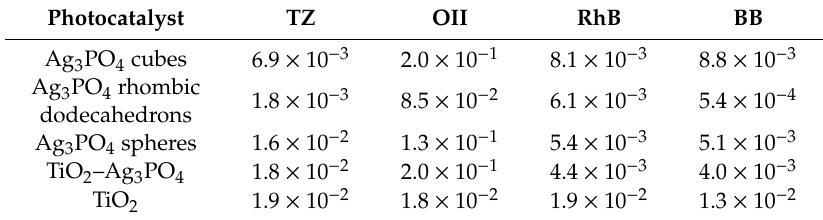
Figure 4. Relative concentration of tartrazine (TZ) ( a ), Orange II (OII) ( b ), rhodamine blue (RhB) ( c ), and Brilliant Blue FCF (BB) ( d ) vs. time in the presence of Ag 3 PO 4 cubes ( ● ), Ag 3 PO 4 rhombic dodecahedrons ( ▲ ), Ag 3 PO 4 spheres ( ▼ ), hybrid Ag 3 PO 4 –TiO 2 ( ♦ ), or TiO 2 ( ■ ) under 420 nm irradiation. Initial concentrations: 5 × 10 − 5 M (dye) and 0.5 g/L (photocatalyst) in aerated aqueous media. Table 2. Pseudo-first order constants (min − 1 ) determined for the photodegradations performed under 420 nm